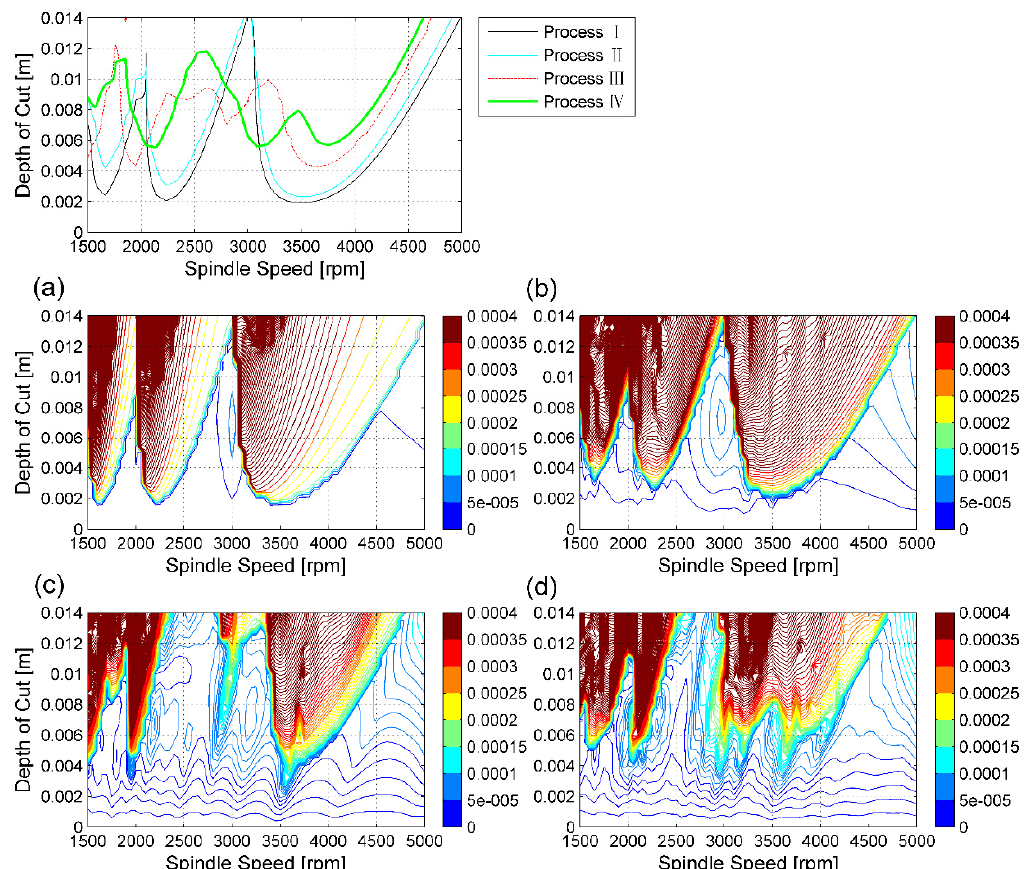
Figure 7. Comparison of the SLDs by theoretical prediction and time-domain simulation for different processes. ( a ) Process I; ( b ) Process II; ( c ) Process III; ( d ) Process IV.